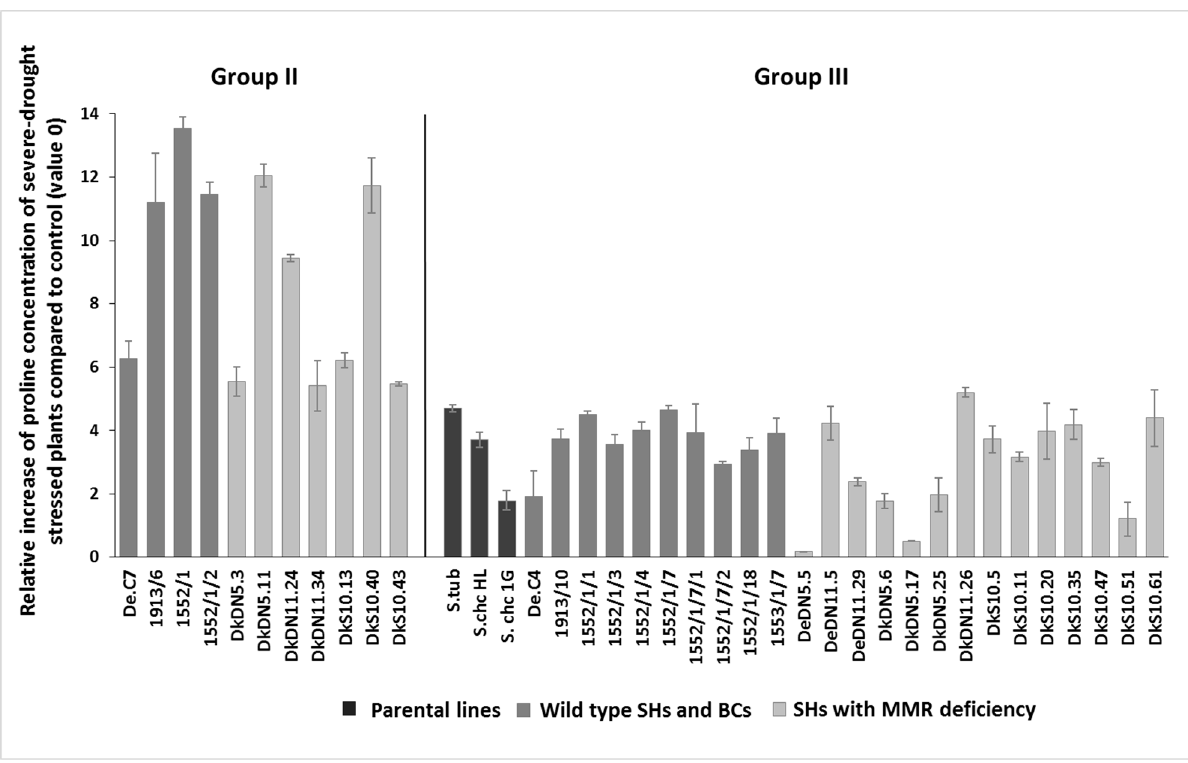
Figure 5. Relative proline concentration changes (mean ± SE, n = 5) during severe water stress of different SHs with or without MMR deficiency, BC progenies, and parental lines ( S. tuberosum and S. chacoense — S.chc HL or 1G).